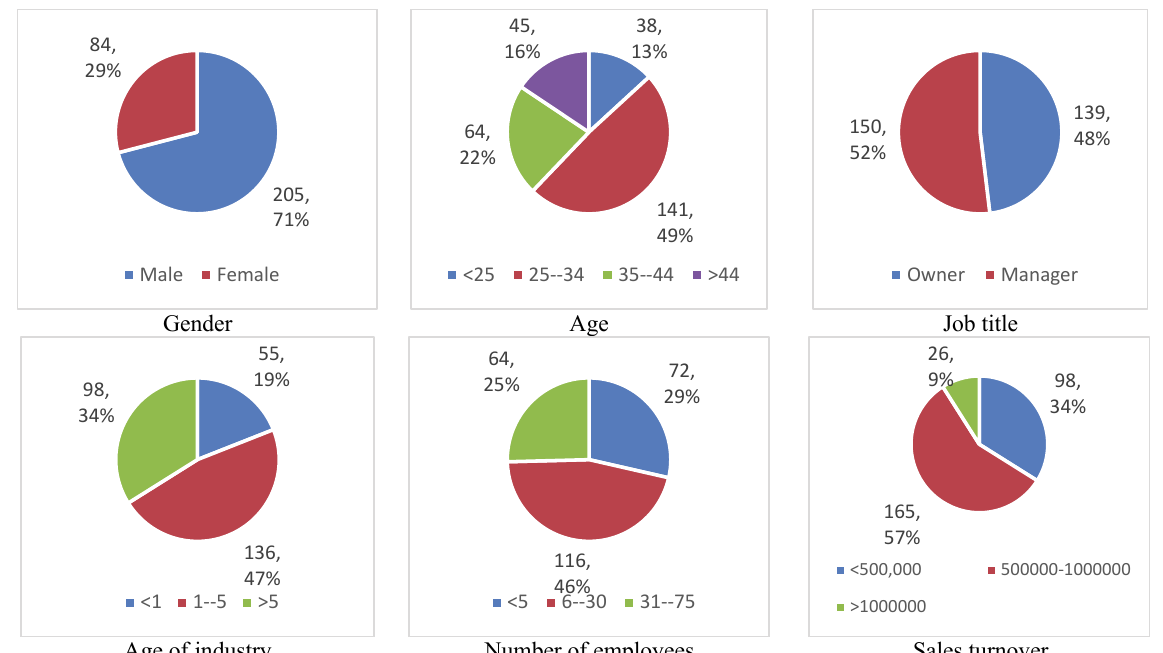
Fig. 1. Demographic characteristics of respondents